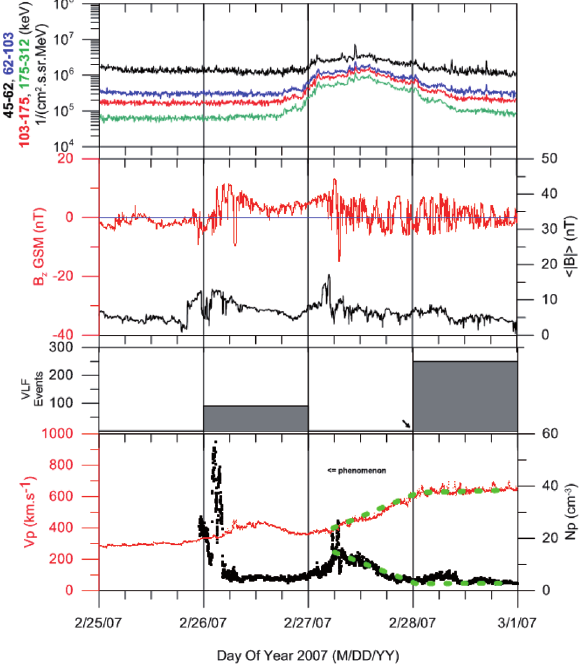
Figure 6. As for Figure 5, for Case B: Feb